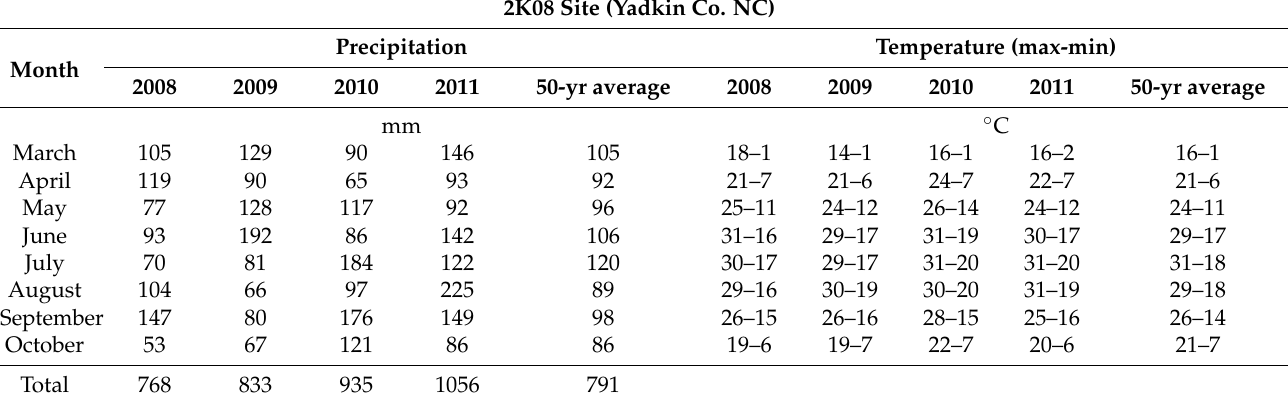
Table 7. Cont. 2K08 Site (Yadkin Co.